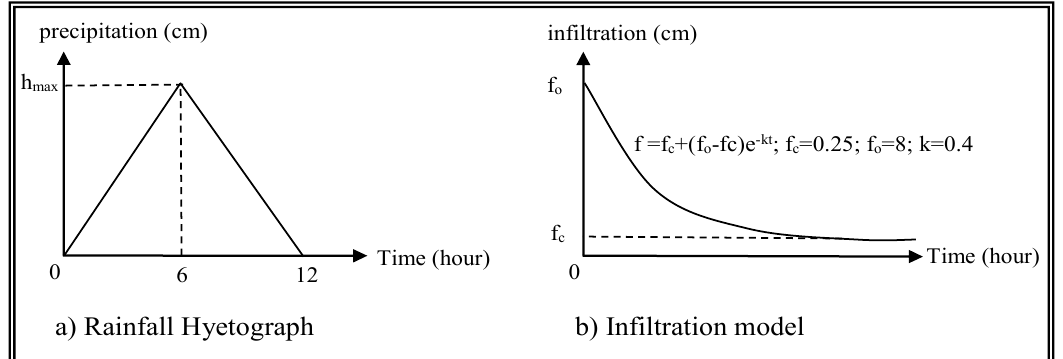
Figure 5. Precipitation and infiltration models. ( a ) rainfall hyetograph, ( b ) infiltration model.